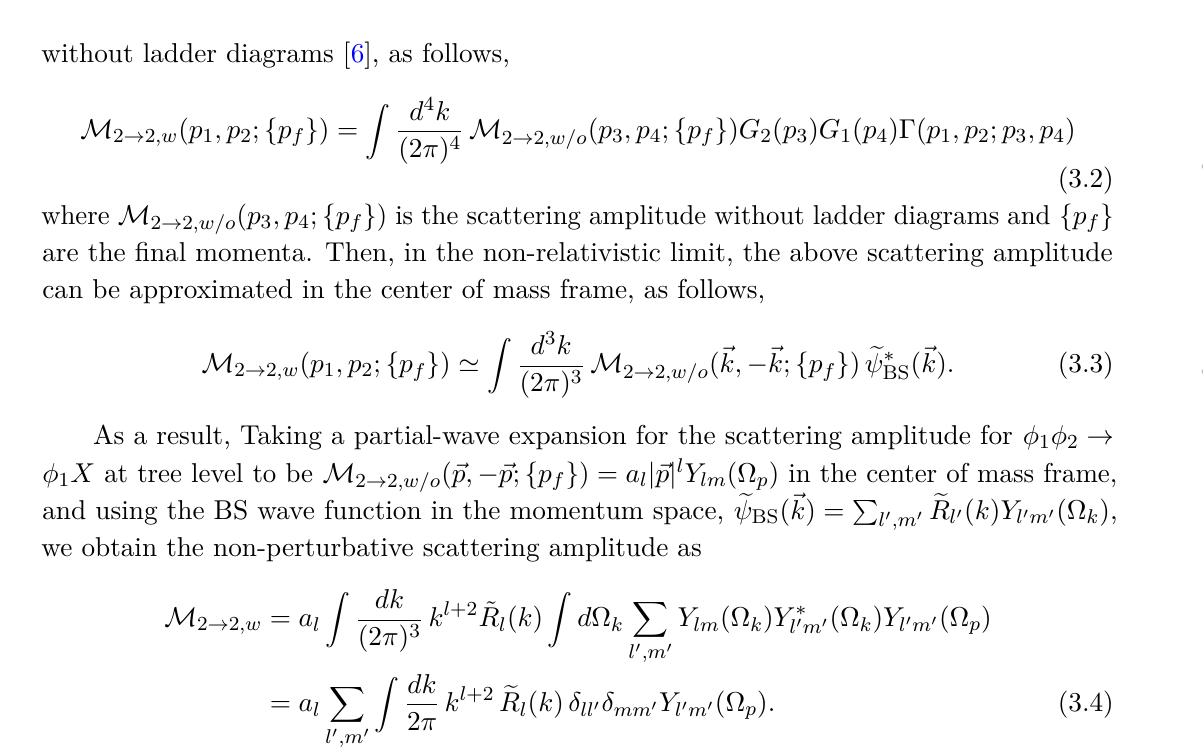
Figure 3 . Feynman diagrams for 2 (above), and the corresponding ladder diagrams